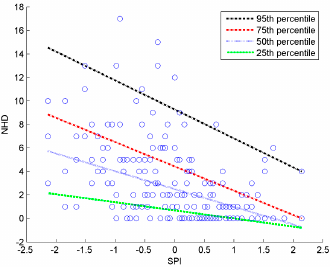
Figure 7. Quantile regression of hot extremes (number of hot days, NHD) with respect to the drought indicator SPI.